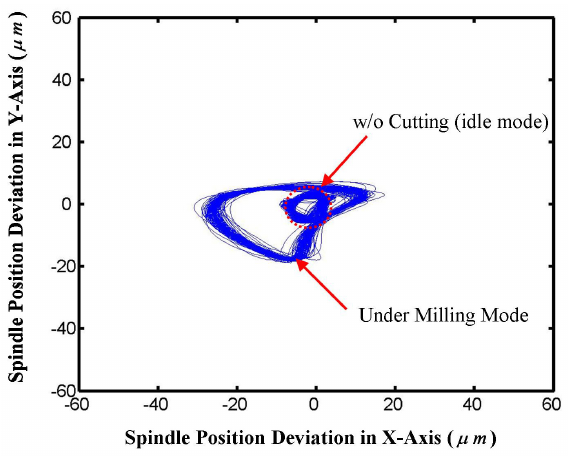
Figure 17. Trajectory of spindle position deviation in X - Y plane (workpiece: acrylic).